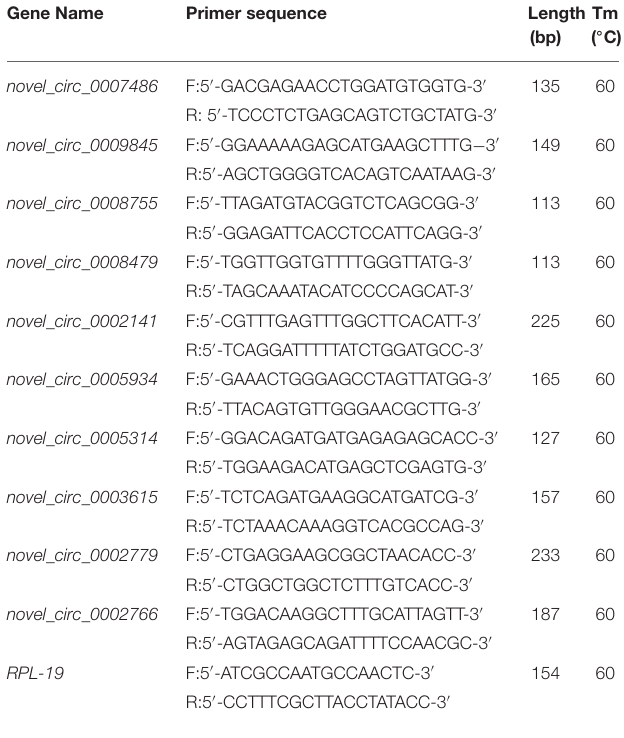
TABLE 1 | RT–PCR primers for detecting